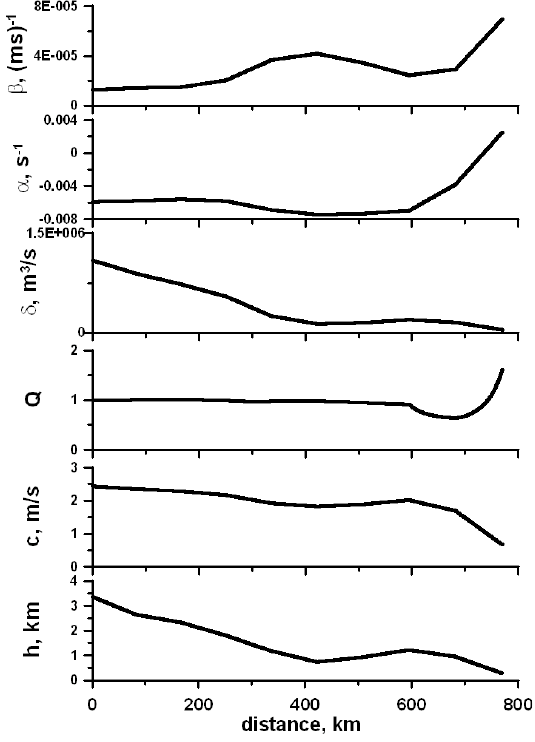
Fig. 15. Coefficients of the evKdV equation (5) along cross-section2.